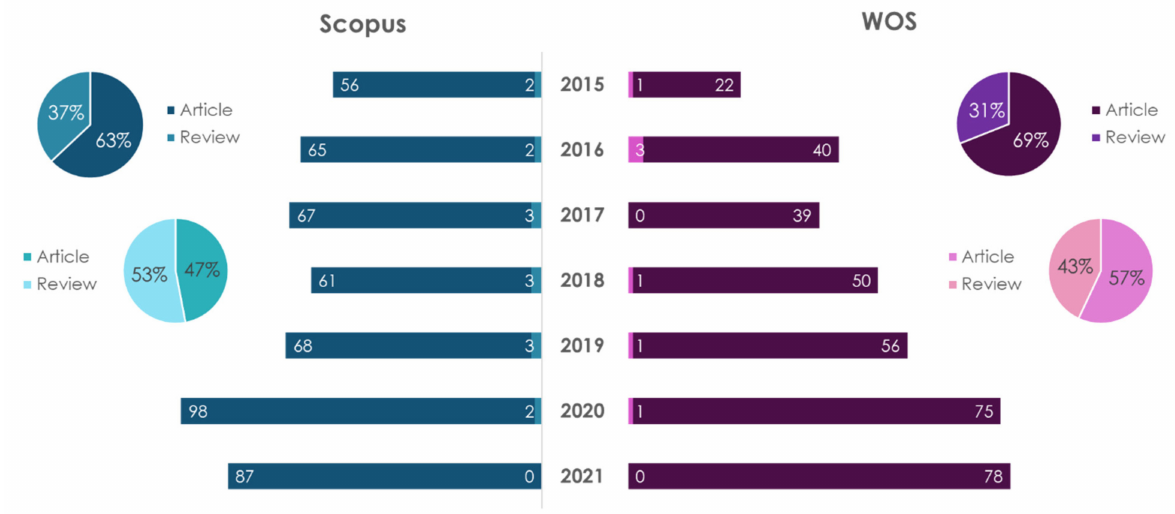
Figure 9. Statistical results of the search in Scopus/WOS databases by the keywords “nutrigenomics” (dark color) and “nutrigenomics and atherosclerosis” (light